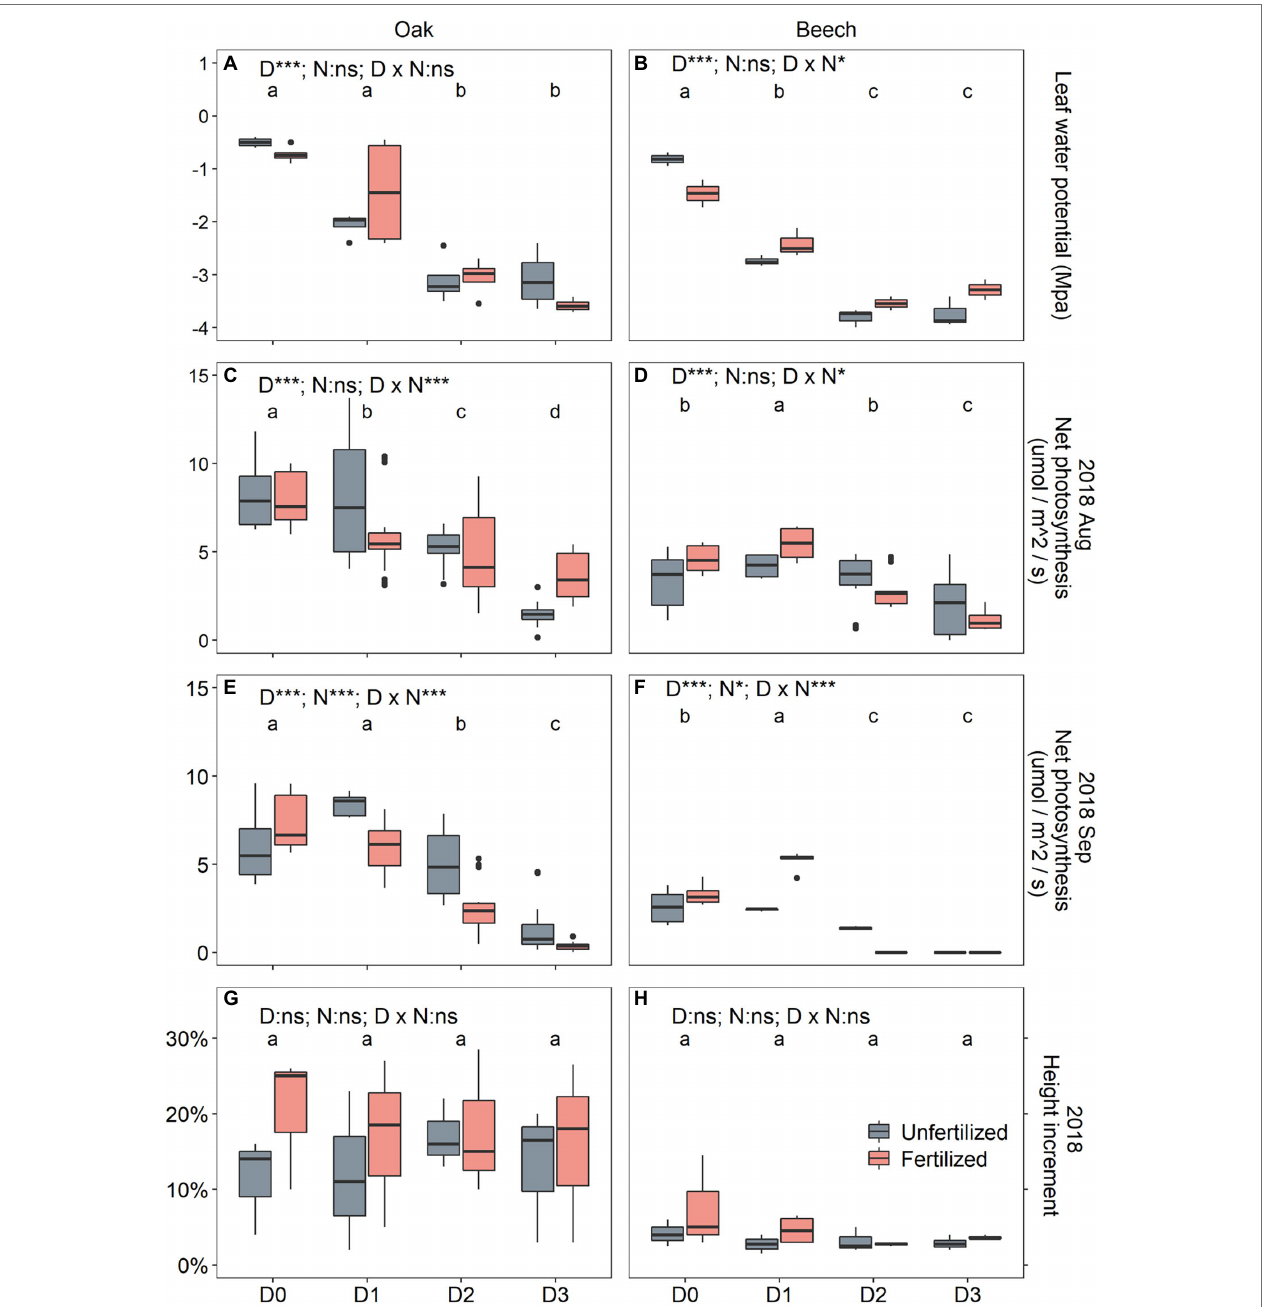
FIGURE 2 | Midday water potential ( ψ leaf ) after 2 months of drought treatment on 5 August 2018 (A,B) , leaf net photosynthesis ( A leaf ) after two (6 August 2018; C,D ) and four (28 September 2018; E,F ) months of drought duration treatment in 2018, and the relative height increment (RHI; G,H ) between 30 May (initial) and 1 October 2018 (after 4 months of drought treatment) for oak ( Quercus petraea ) and beech ( Fagus sylvatica ) saplings. D0 (watering weekly), D1 (watering biweekly), D2 (watering monthly), and D3 (watering bimonthly) represent the drought duration. Different letter indicates significant difference in parameters among D0, D1, D2, and D3.